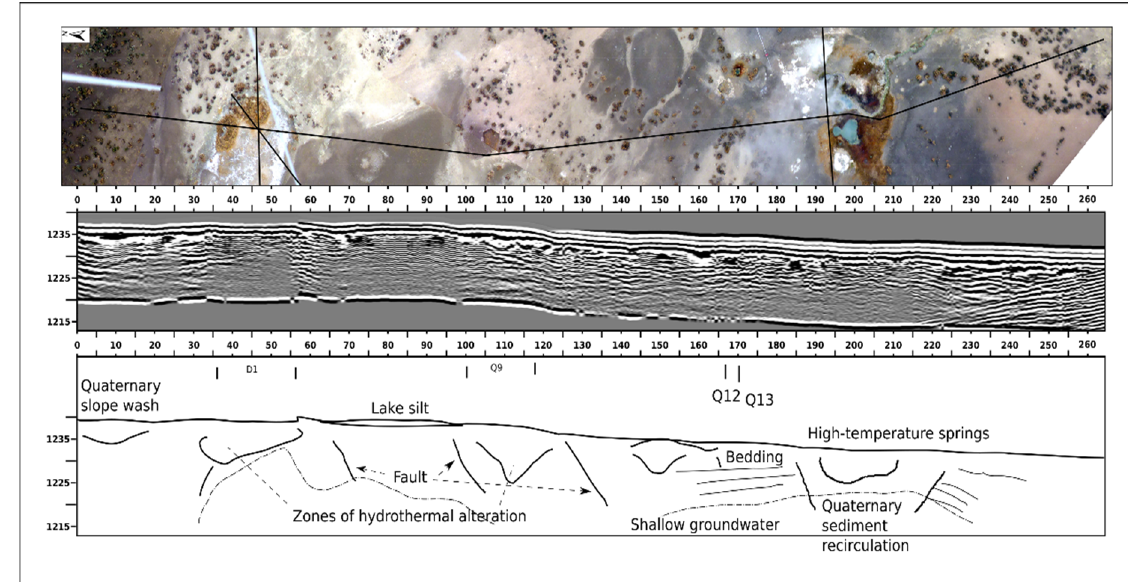
Figure 18. GPR transect 2 from north to south crossing sinter feature D1, the west flank of the sinter apron of Q9, and the high-temperature spring area, terminating at the south fence of the ACEC. Three normal faults are interpreted from the GPR data, striking northeast. These faults control the elevation of the topographic bench at 1235 m and may provide permeable pathways for the spring water (Figure S3: GPR raw data and topographically corrected data for Track 2, 50 MHz).